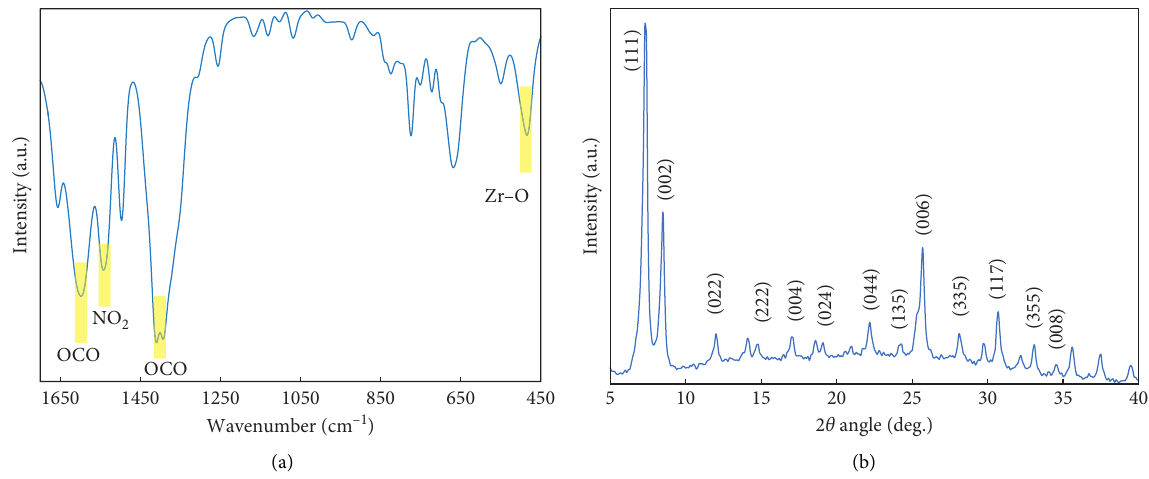
Figure 2: FTIR spectra (a) and XRD diffractogram (b) of prepared UiO-66-NO